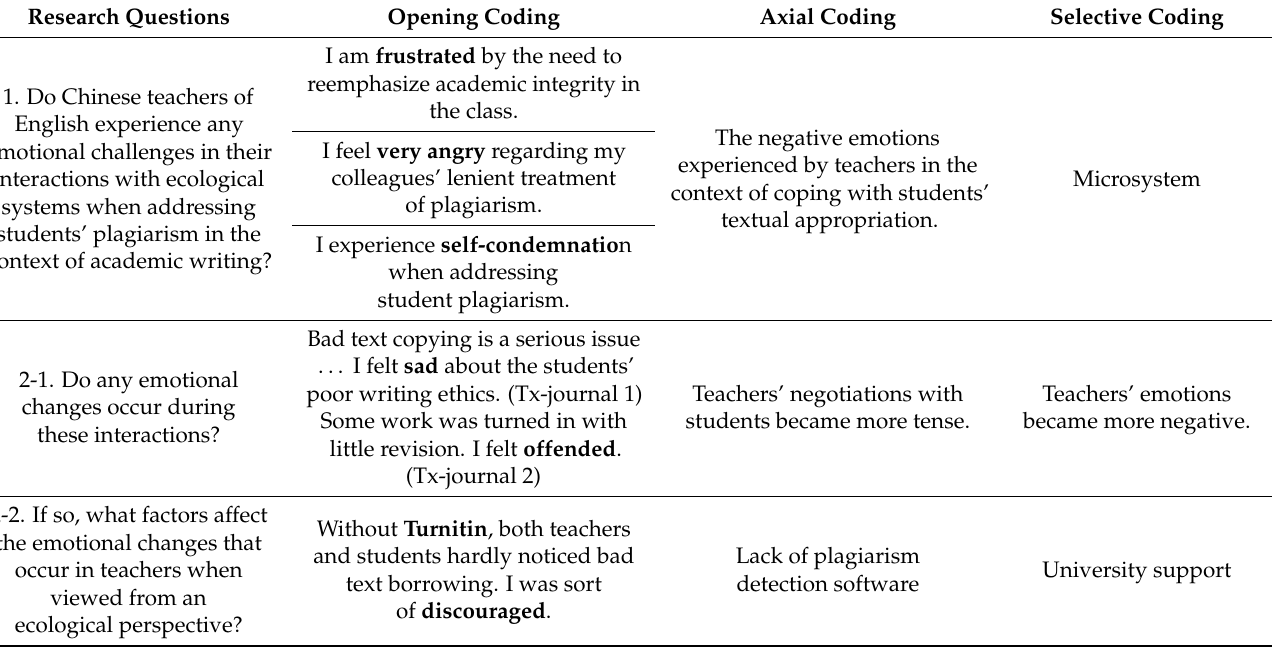
Table 2. Table 2. Sample data